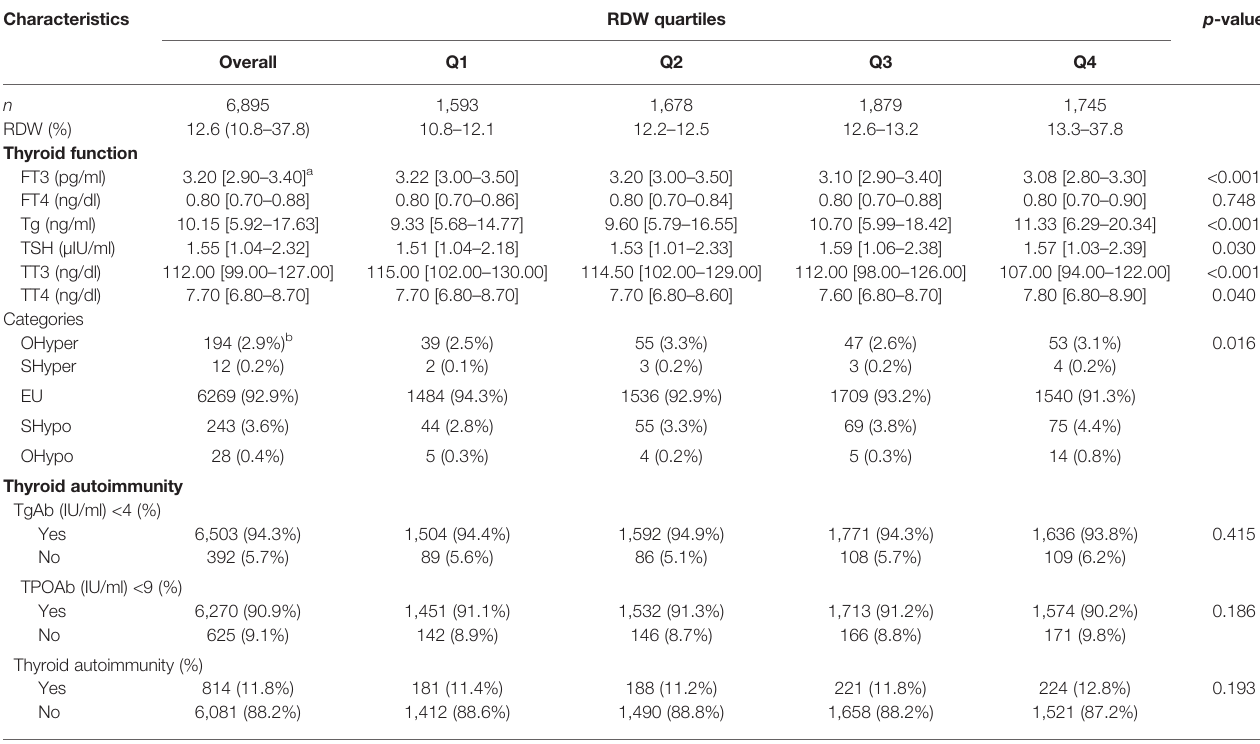
TABLE 1 | Thyroid function of NHANES (2007 – 2010) study population in RDW